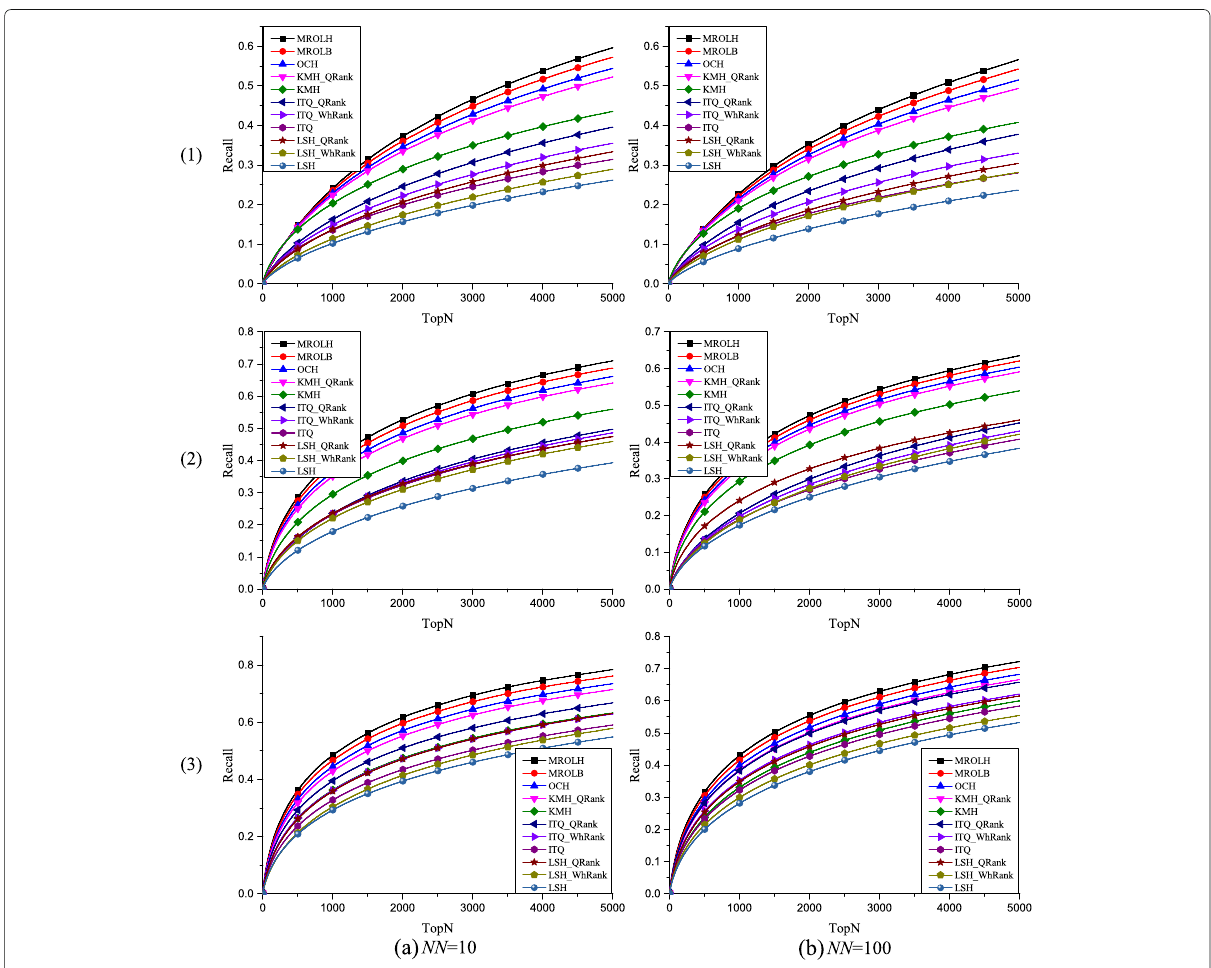
Fig. 4 The recall curves of the comparative experiments in the GIST1M dataset. The data are separately mapped into 32-, 64-, and 128- bit binary codes in the (1), (2), and (3) rows. The number of the true nearest neighbors in columns a and b separately are 10 and